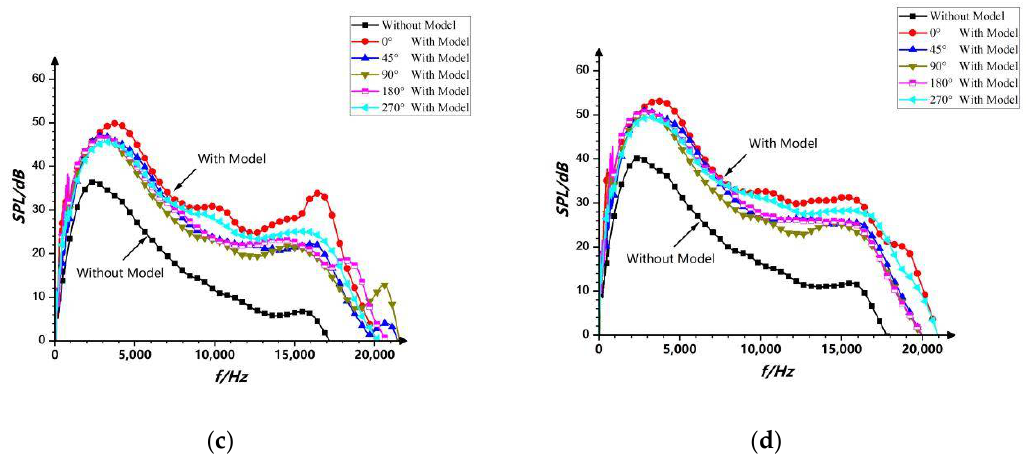
Figure 15. Comparison of spectrograms with or without models. ( a ) wind speed at 25 m/s; ( b ) wind speed at 30 m/s; ( c ) wind speed at 35 m/s; ( d ) wind speed at 40 m/s.